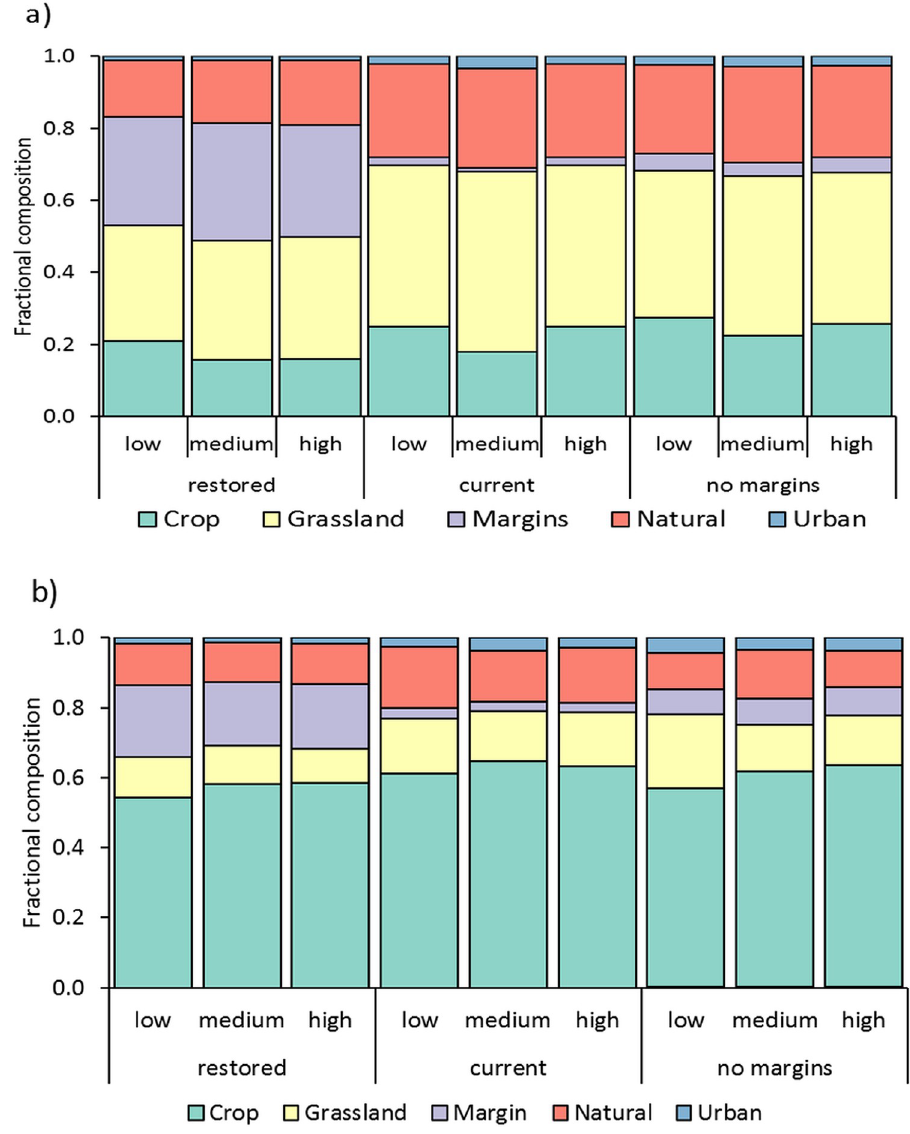
Fig 6. Land cover classes traversed by least-cost paths for each of the three agricultural margin scenarios crossed with the three resistance scenarios. a) Land cover classes for the Central Valley study area and b) the close-up study area. All of the crops are condensed into a single category, and the three urban categories have been condensed into a single category.